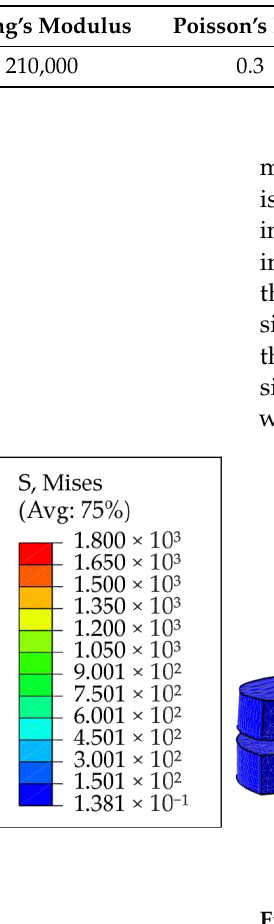
Figure 5. Global model and crack growth simulation from Adapcrack3D: ( a ) Global model generated by Adapcrack3D for the first step, inserted initial crack in inset; ( b ) Crack growth simulation in the punch-sided sheet as calculated by Adapcrack3D, initial crack, and the crack fronts in inset.